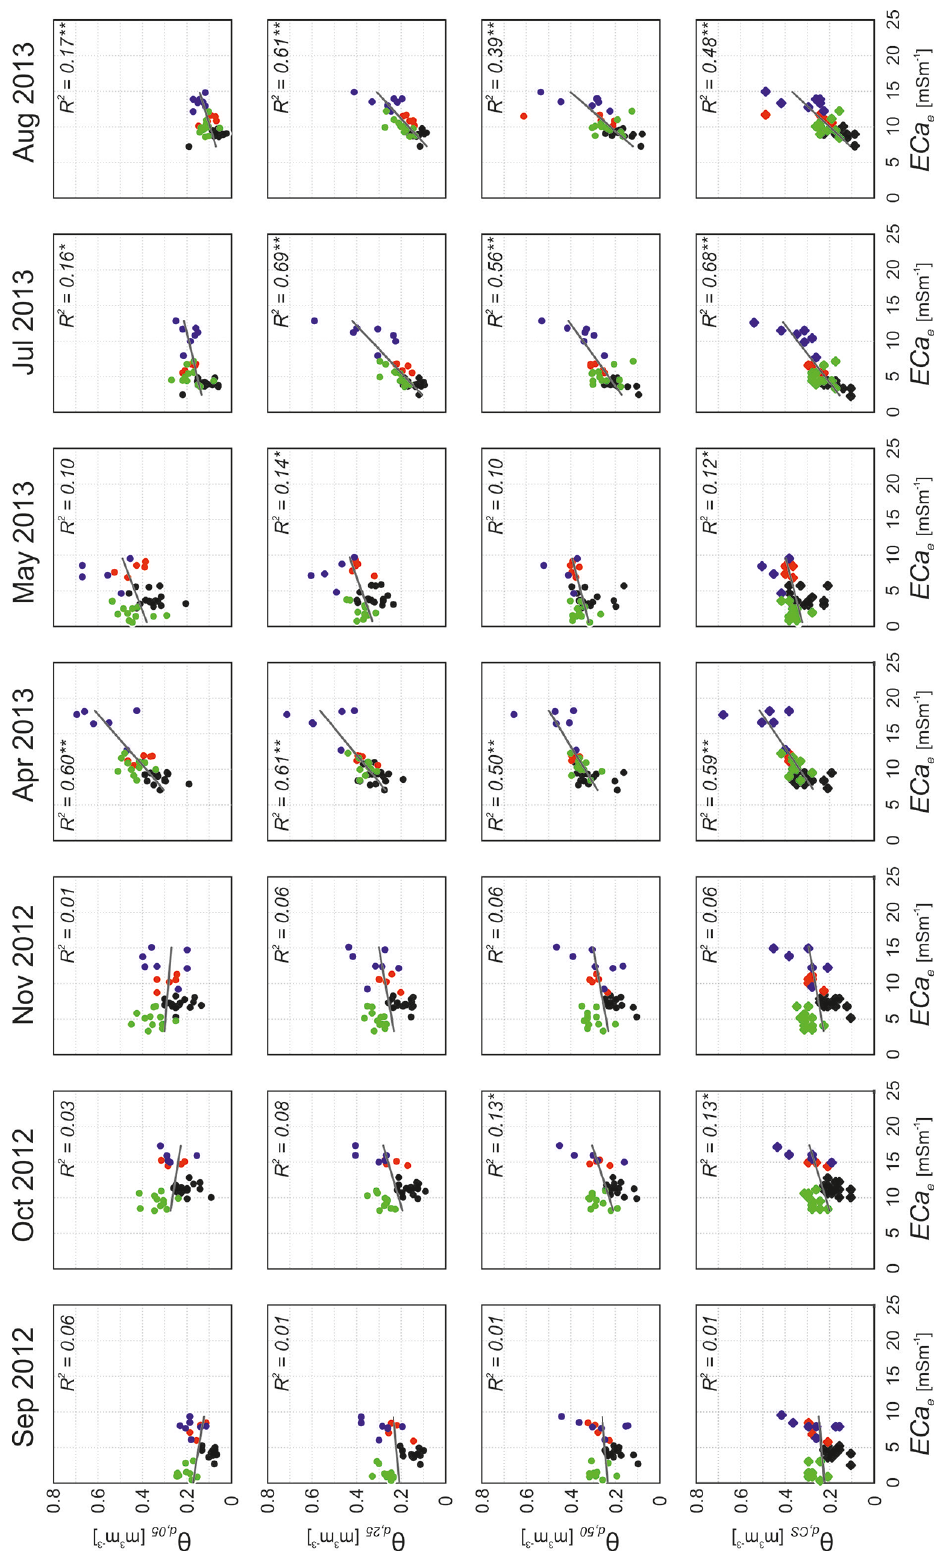
Figure 4. Linear regression between ECa e and θ d for every EMI measurement date and every depth of soil moisture monitoring ( θ d,05 , θ d,25 and θ d,50 , respectively), as well as for the integrated soil moisture calculated using the cumulative sensitivity function ( θ d,CS ) . The different colors represent measurement points located within: STU 1 – black dots; STU 2 – red dots; STU 3 – blue dots; and STU 4 – green dots. Regression coefficients R 2 are indicated; the significance levels p < 0.05 and p < 0.01 are indicated as ∗ and ∗∗ ,